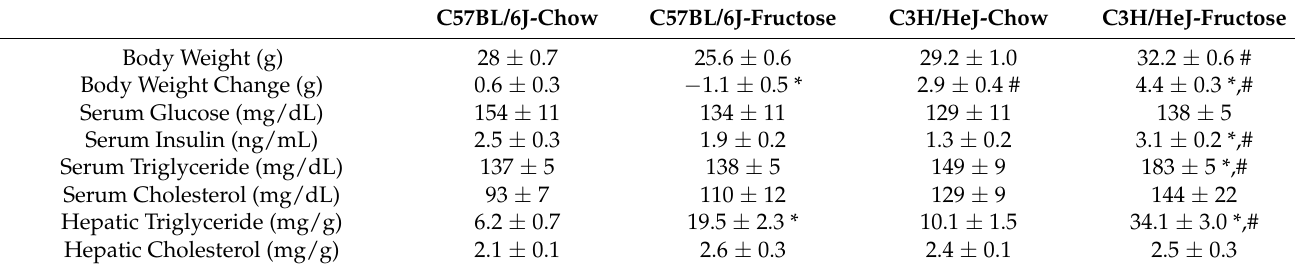
Table 1. Metabolic phenotype in male C57BL/6J versus C3H/HeJ mice fed chow versus high-fructose diet for 6 weeks.